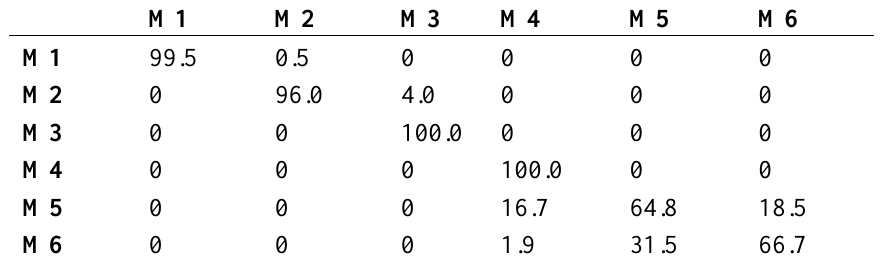
Table 4. Confusion matrix for the motion recognition from LS-SVM classifier (Unit: